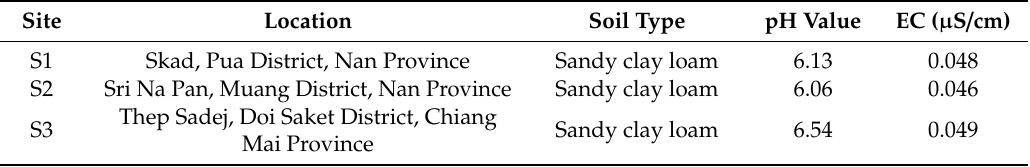
Figure 1. Map showing the location of sample collection sites. Table 1. Location, soil type, pH value and electrical conductivity of collected soil